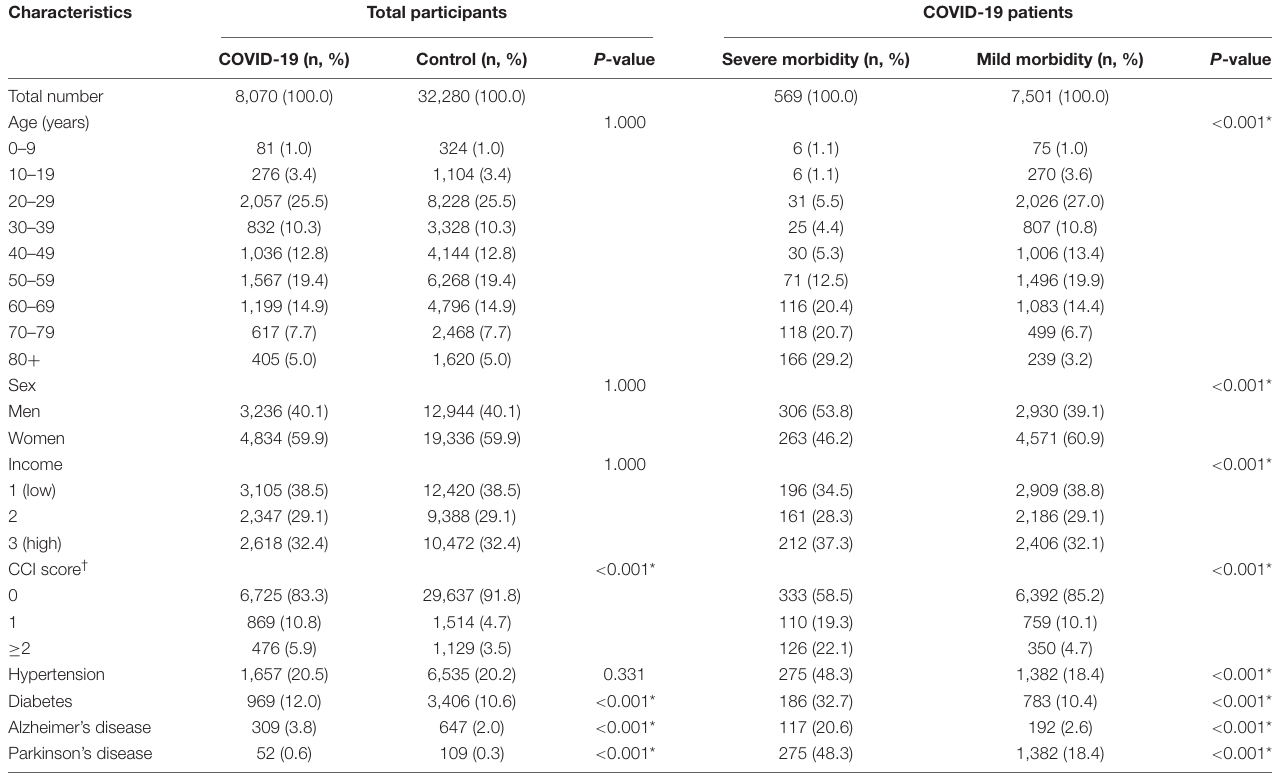
TABLE 1 | General characteristics of the participants.